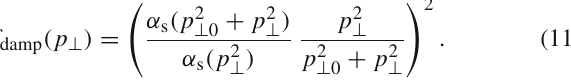
Fig. 1 Total,nondiffractive(ND),elastic(el)anddiffractive/excitation (D/E) cross sections for some common collision processes, a pp, b π + p, c π − p and d K + p. Full lines show the cross sections actually used, while dashed show the low-energy (LE) and dash-dotted the high-